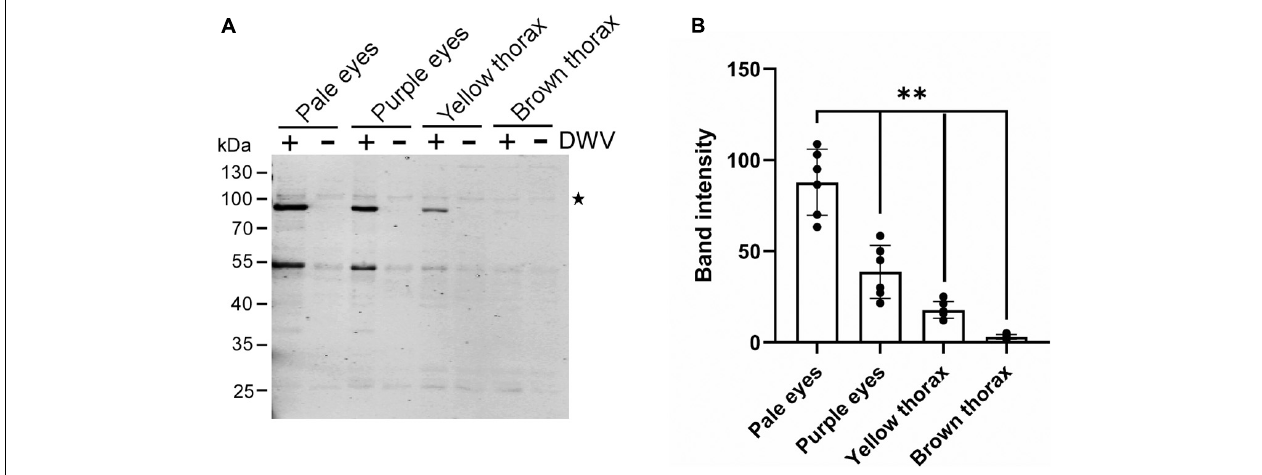
FIGURE 2 | DWV infection of honey bee pupal head tissues at the different developmental stages. (A) Pupal head tissues at four different developmental stages (pupa with pale eyes, purple eyes, yellow thorax, and brown thorax) were infected with DWV and then RdRP synthesis was tested. (B) Band intensity of the RdRP precursor was compared between the four groups using the one-tailed Dunnett test and P -values between pale eyes and purple eyes, yellow thorax, or brown thorax are < 2.2 × 10 − 6 , < 1.3E × 10 − 6 < 1.3 × 10 − 6 , respectively (**). Mean values ± SD (error bars) are shown ( n = 6). *This represents statistical